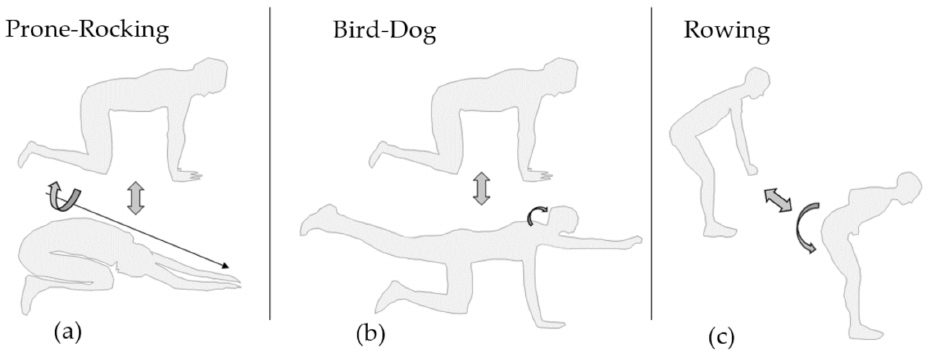
Figure 5. TCM: Exercises performed with a typical compensatory movement ( a ) Prone-Rocking, ( b ) Bird-Dog and ( c ) Bent-over